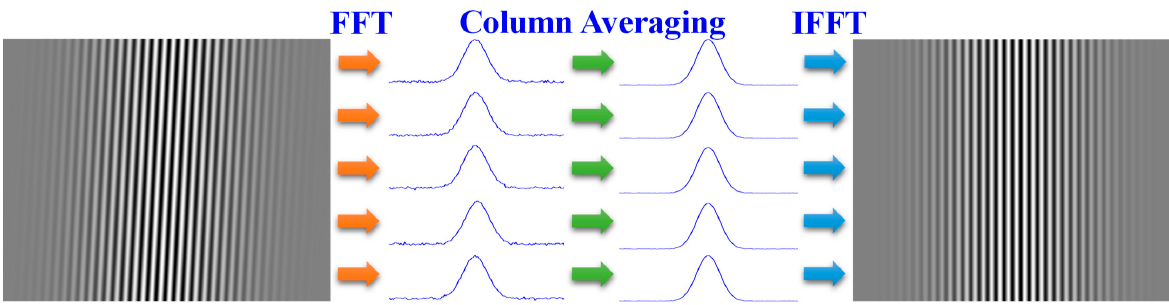
Figure 7. Row-by-row FFT-IFFT.